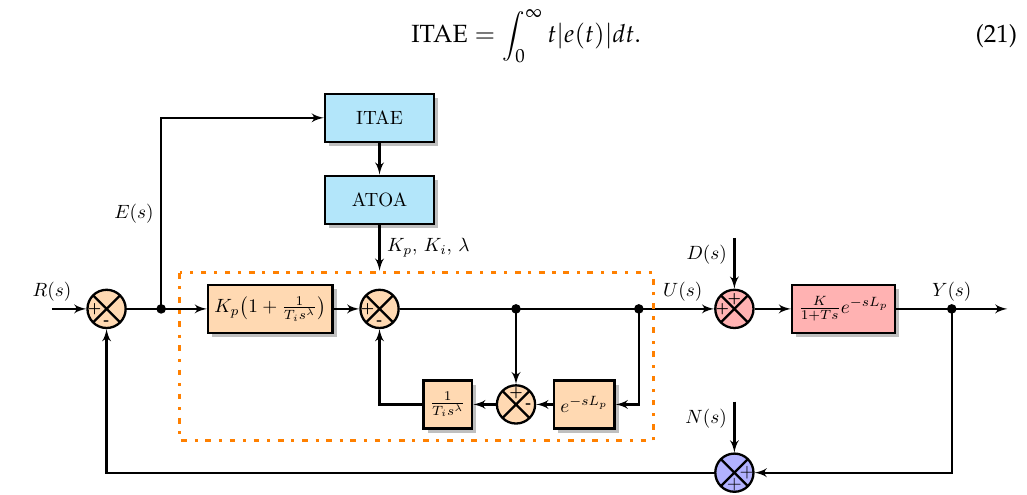
Figure 7. Closed-loop control system with the FOPPI controller in presence of